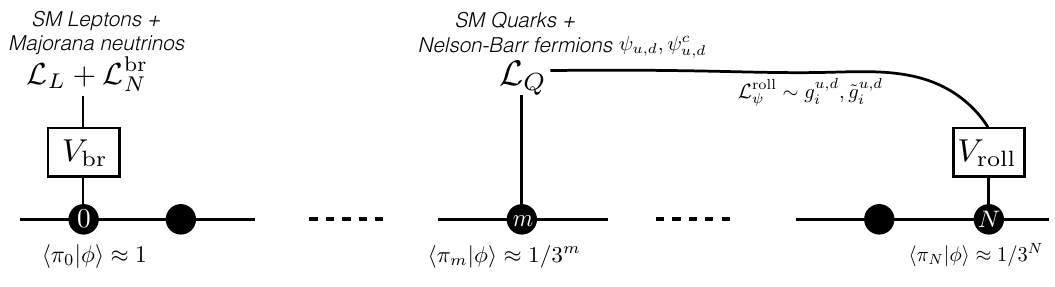
Figure 1 . Cartoon of the hierarchion construction. The Standard Model lepton sector, eq. (4.1), is connected to the 0 th site through higher dimension operators (cid:18)a la Froggatt-Nielsen. On the same site, the sterile neutrino sector, \backreaction" potential for the hierarchion, V br in eq. (2.4). The quark sector, can also be connected (cid:18)a la Froggatt-Nielsen to the m th site, where 0 vector-like Weyl fermions, ( u ; c